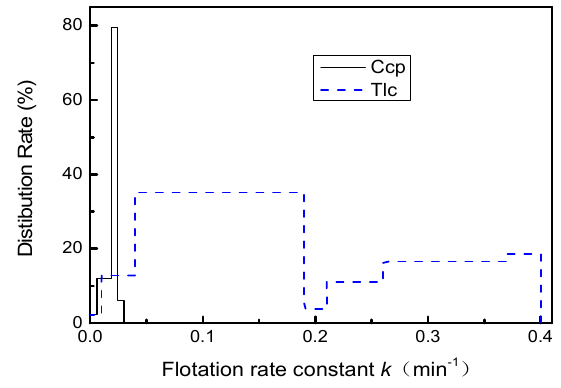
Figure 4. Distribution of k values without collector.